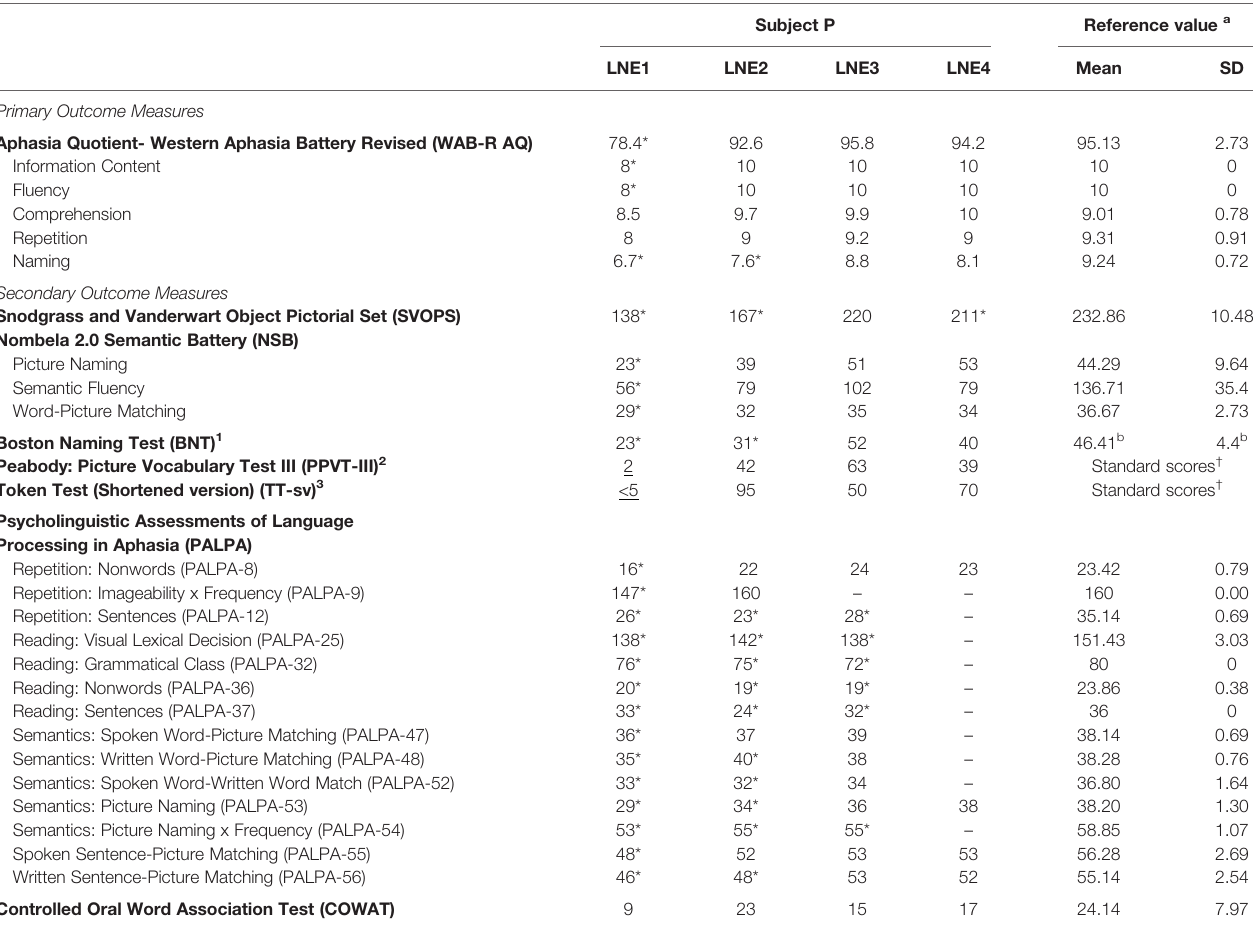
TABLE 1 | Language